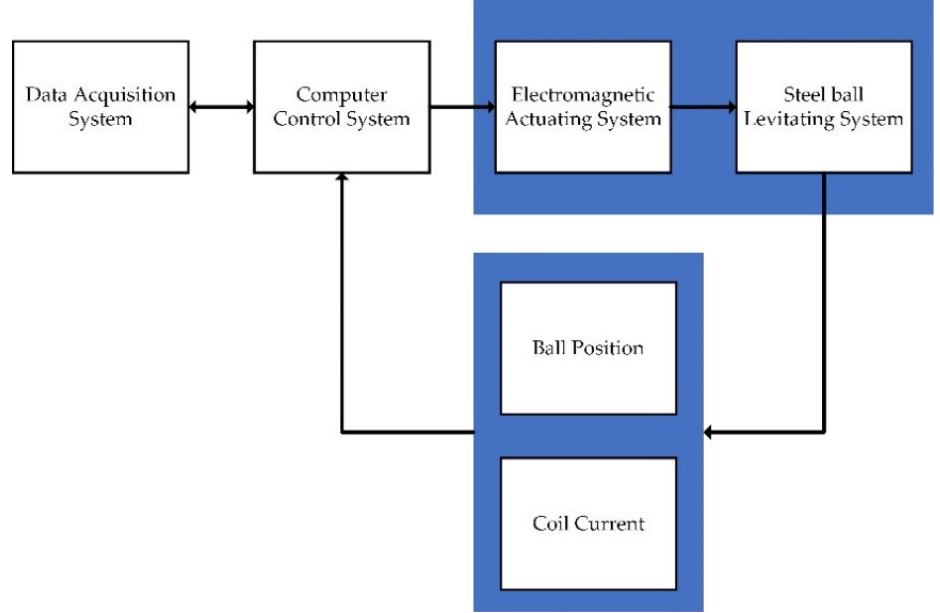
Figure 5. Block diagram of the Magnetic Levitation (MAGLEV)